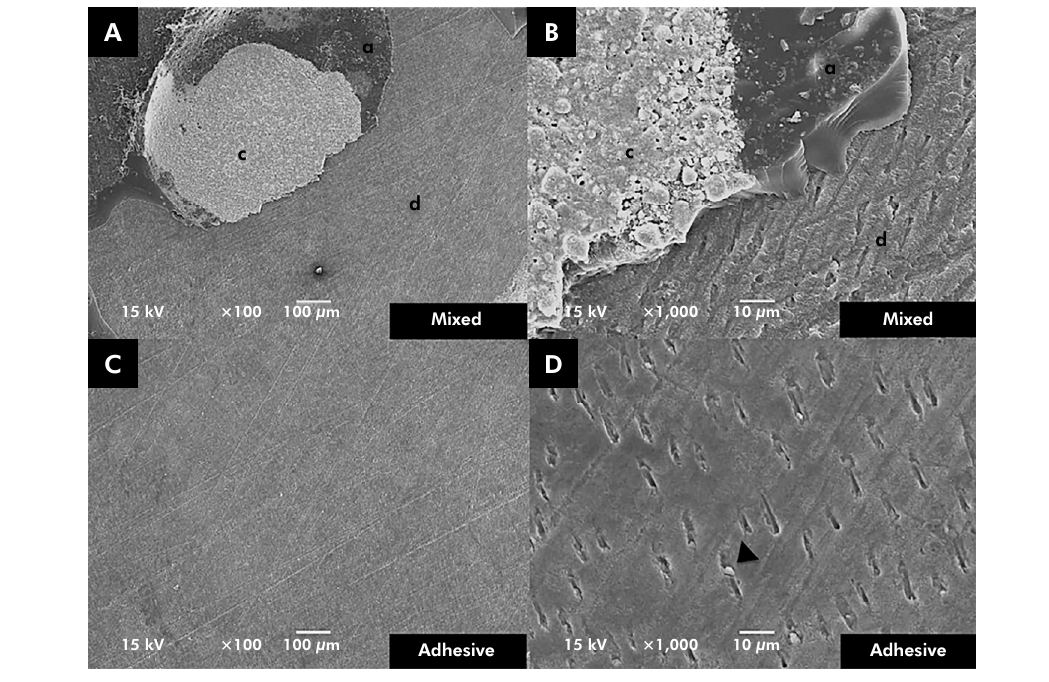
Figure 6. SEM micrographs of debonded specimens of etch-and-rinse adhesive system. Images A and B (1CQ:1TPO) show mixed failure, with remnants of adhesive (a) and resin composite (c) attached to dentin (d). Images C and D (1CQ:3TPO) show adhesive failure with adhesive remnants in the dentin tubules.